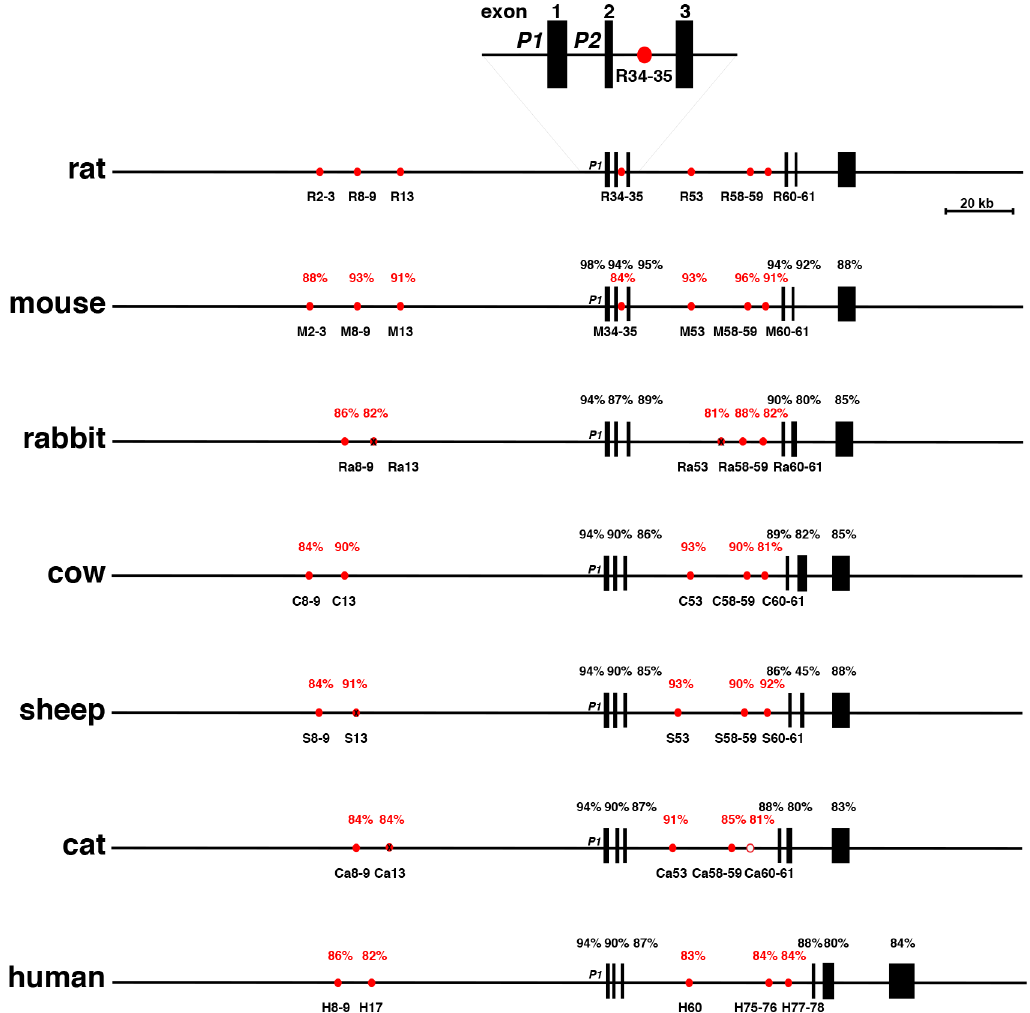
Fig 7. Comparison of mammalian IGF1/Igf1 genes and loci. Schematics of rat Igf1 , and selectedother IGF1 / Igf1 genes and loci are shown. Exons are depictedas boxes, and introns and flanking DNA as horizontallines. The enlargementabovethe main map depicts the two rat Igf1 promoters, P1 and P2, and exons 1–3. Red circles represent locationsof sites shown to bind Stat5b in a GH-inducible way in the rat Igf1 locus, and their homologues in other species. A filled circle indicatesthe presenceof intact Stat5b bindingelements,an open circle depicts that one Stat5b site is absent, and an X within a circle represents the absenceof all Stat5b bindingsequences(see Tables 5 and 6). The percentage of nucleotideidentity with different parts of rat Igf1 is indicatedwithin each gene and locus (black for exons, red for putative Stat5b bindingelements). Other abbreviations are as follows: R2-3, R8-9, R13, R34-35, R53- 54, R57-59,R60-61-78—nomenclature for rat Stat5b sites (see (37)). A similar nomenclature has been adoptedfor other species.